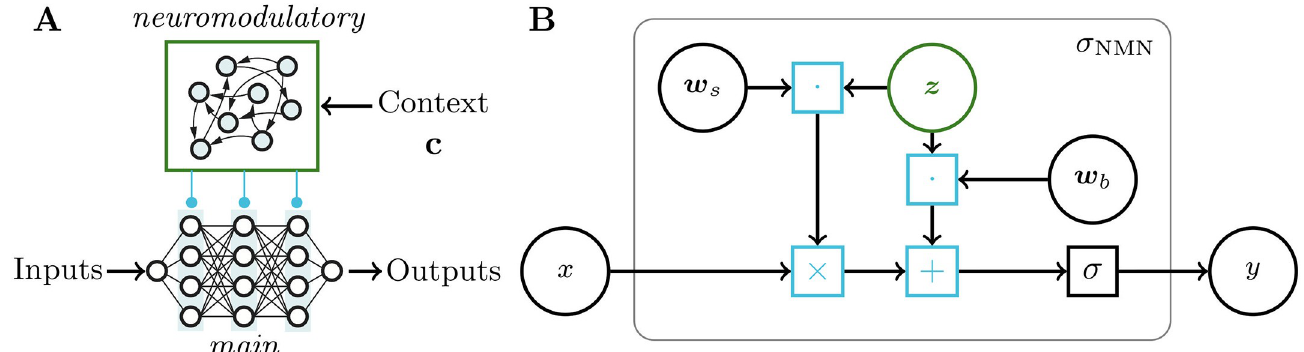
Fig 1. Sketch of the NMN architecture. A . The NMN is composed of the interaction of a neuromodulatory neural network that processes some context signal (top) and a main neural network that shapes some input-output function (bottom). B . Computation graph of the NMN activation functions σ w are parameters controlling the scale factor and the offset of the activation function σ , respectively. z is a context-dependent variable computed by the b neuromodulatory